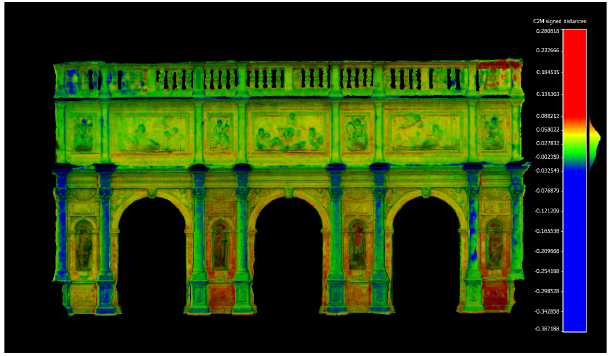
Figure 15. Comparison mesh to mesh (M2M).